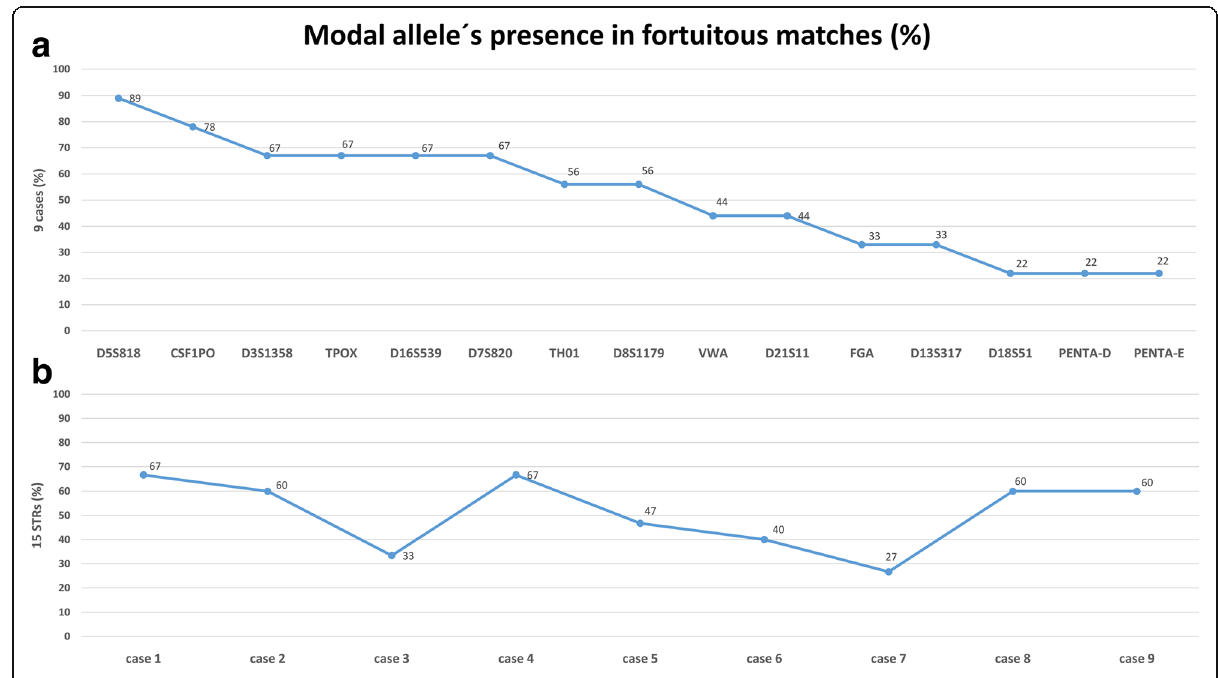
Fig. 2 Modal allele presence in the nine fortuitous matching cases observed in the Mexican STR database: a By locus; b By case